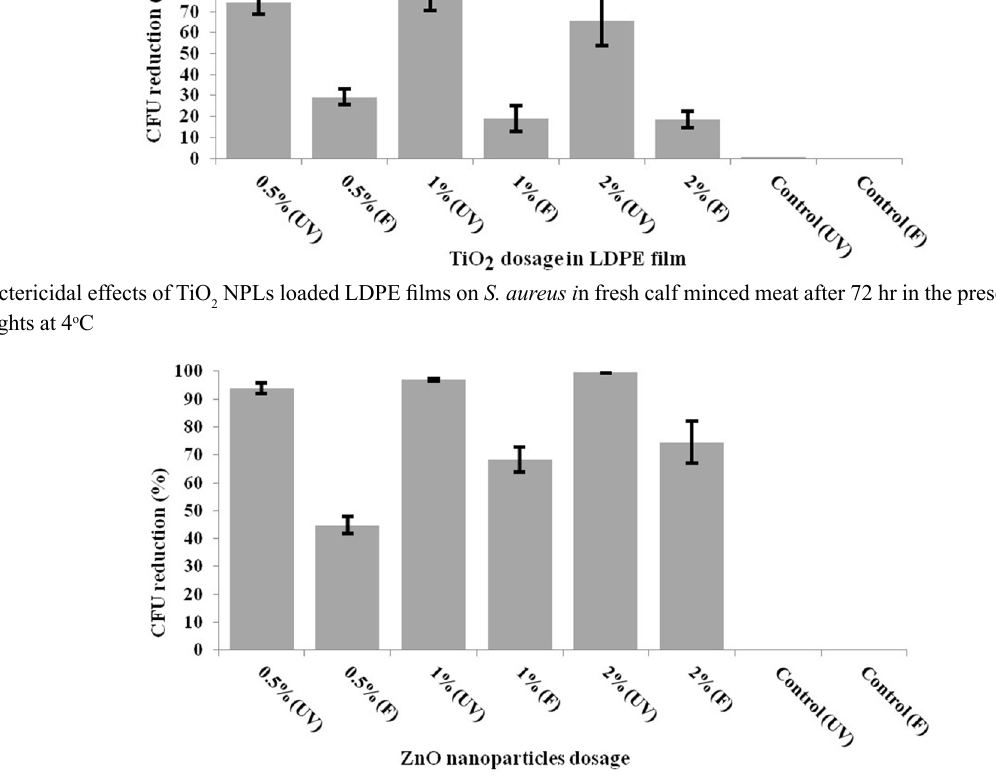
Fig. 4. Direct bactericidal effects of ZnO NPLs loaded LDPE films on S. aureus after 72 hr in the presence of fluorescent and UV lights at